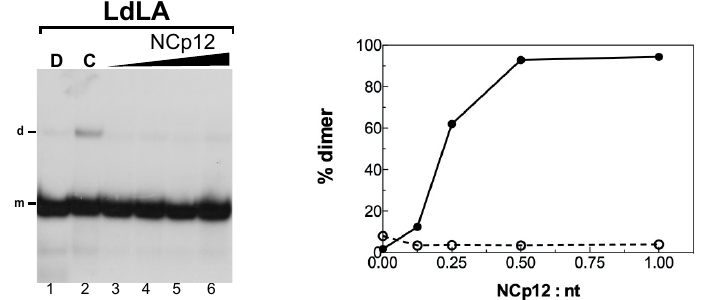
Figure 6. Deletion of loop A and the G bulge prevents NCp12-mediated L3 RNA dimerization. The 5 ′ -end-labeled LdLA RNA in the absence (lane C) or the presence of NCp12 (lanes 3–6) was incubated at 37 °C as described in Materials and Methods. After phenol–chloroform extraction, the samples were analyzed by electrophoresis on a 12% polyacrylamide gel at 25 °C in the TBE buffer. Heat-denatured LdLA RNA (lane D) was used to identify the band corresponding to monomeric LdLA RNA. Lanes 3–6, protein to nucleotide molar ratios were 1:8, 1:4, 1:2, and 1:1. The monomeric and dimeric forms of LdLA RNA are indicated by m and d, respectively. The graph was derived from the gels shown in this figure and Figure 4. Filled circles, Lwt; open circles, LdLA.